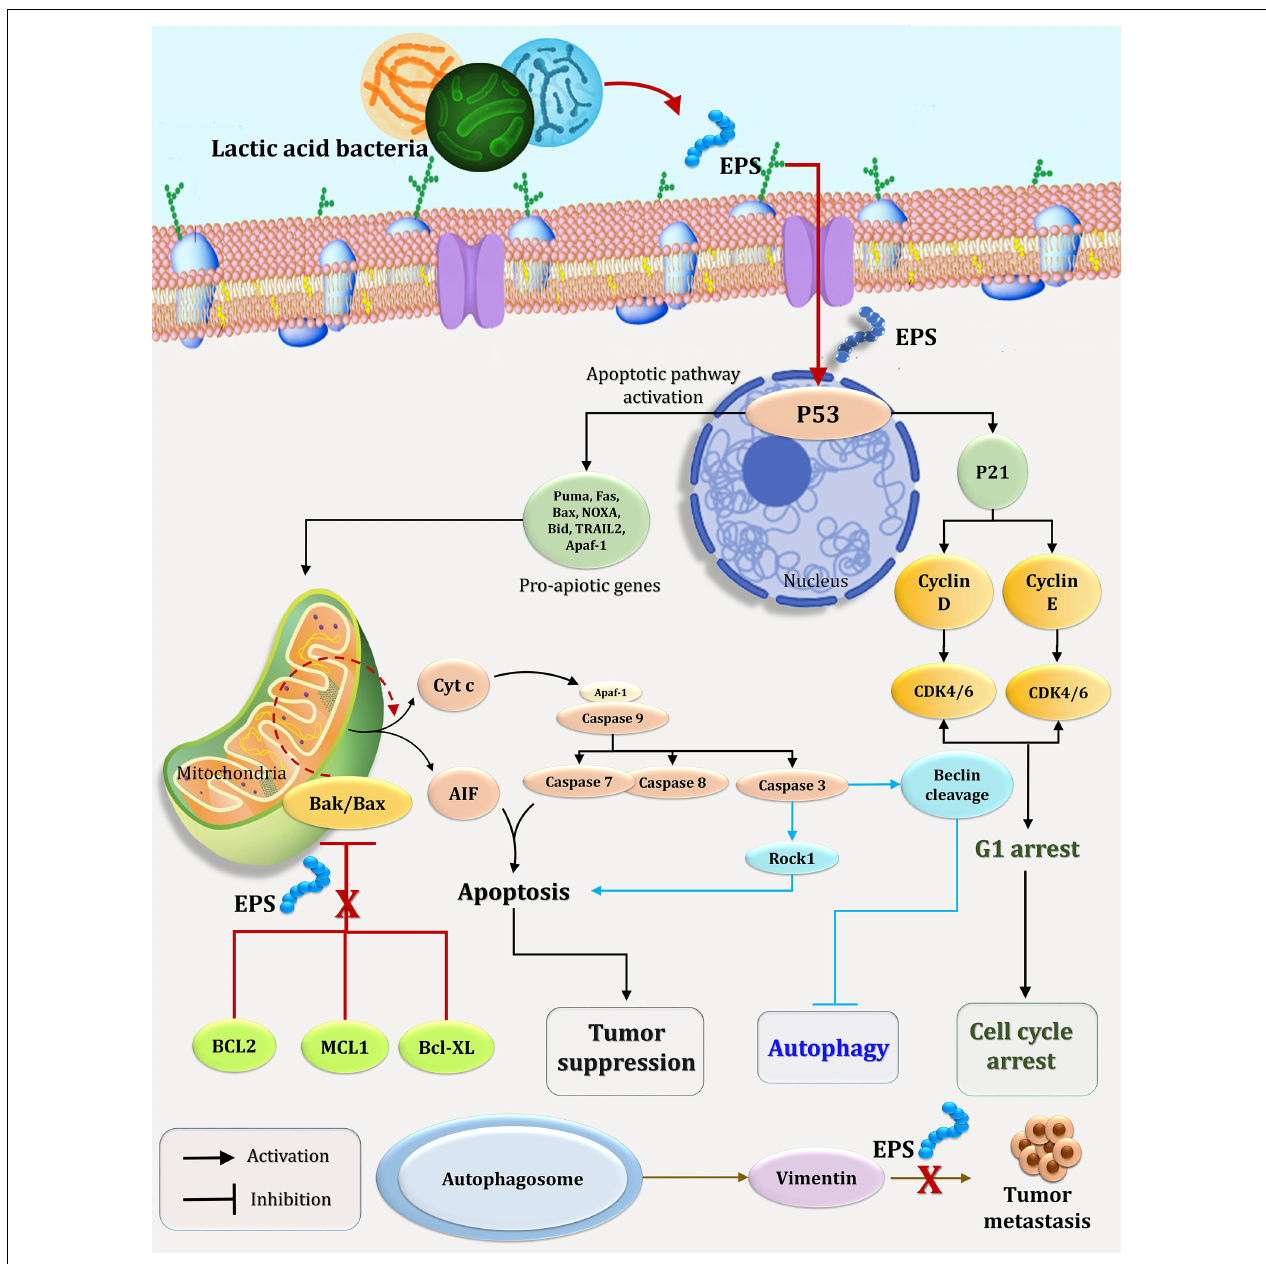
Figure 10 | A possible mechanism for EPS 5 ’s effect on the cell cycle and apoptosis in cancer